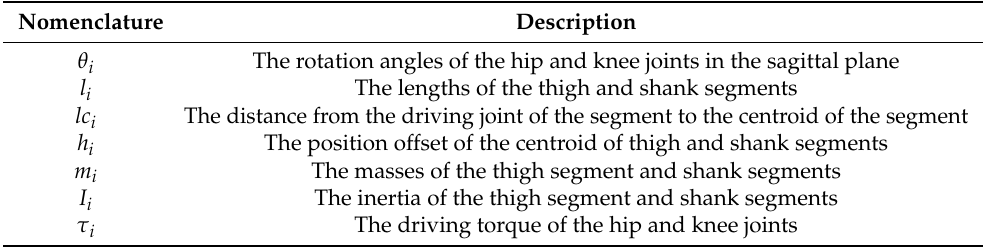
Figure 2. Simplified structural diagram of a unilateral lower limb. Table 2. The physical parameters of the simplified